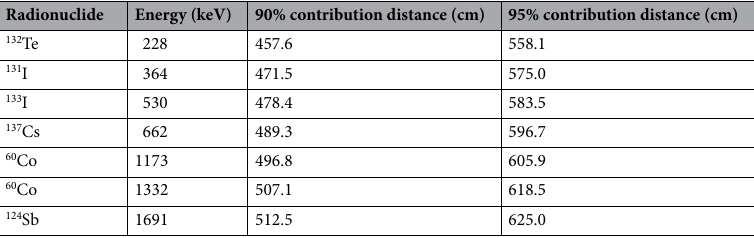
Table 3. Contribution distance to γ-ray of different